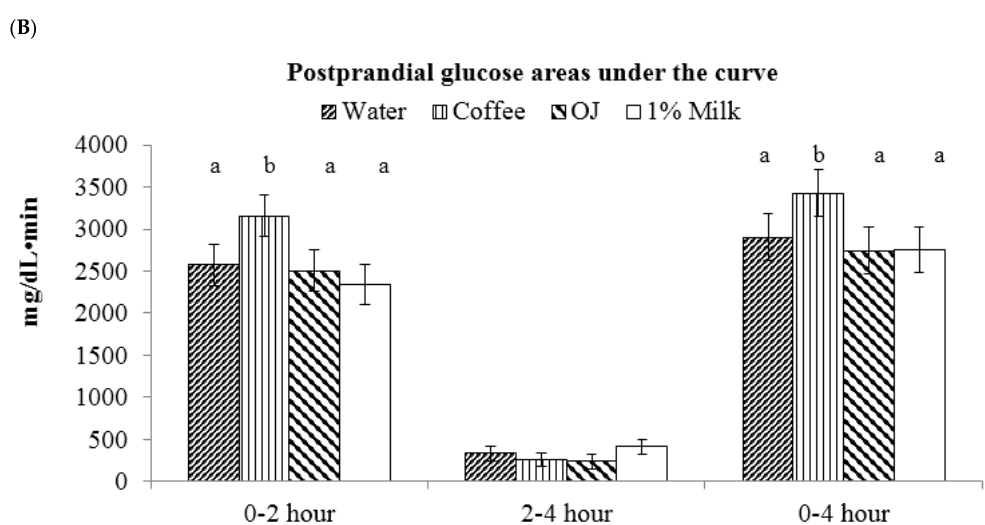
Figure 2. Postprandial plasma glucose responses to breakfast meals consumed with test beverages. ( A ) Changes in glucose concentrations during meal glucose tolerance tests; ( B ) Glucose incremental area under the curve. a,b Bars with different letters (during the same time frame) were significantly different, p < 0.05.